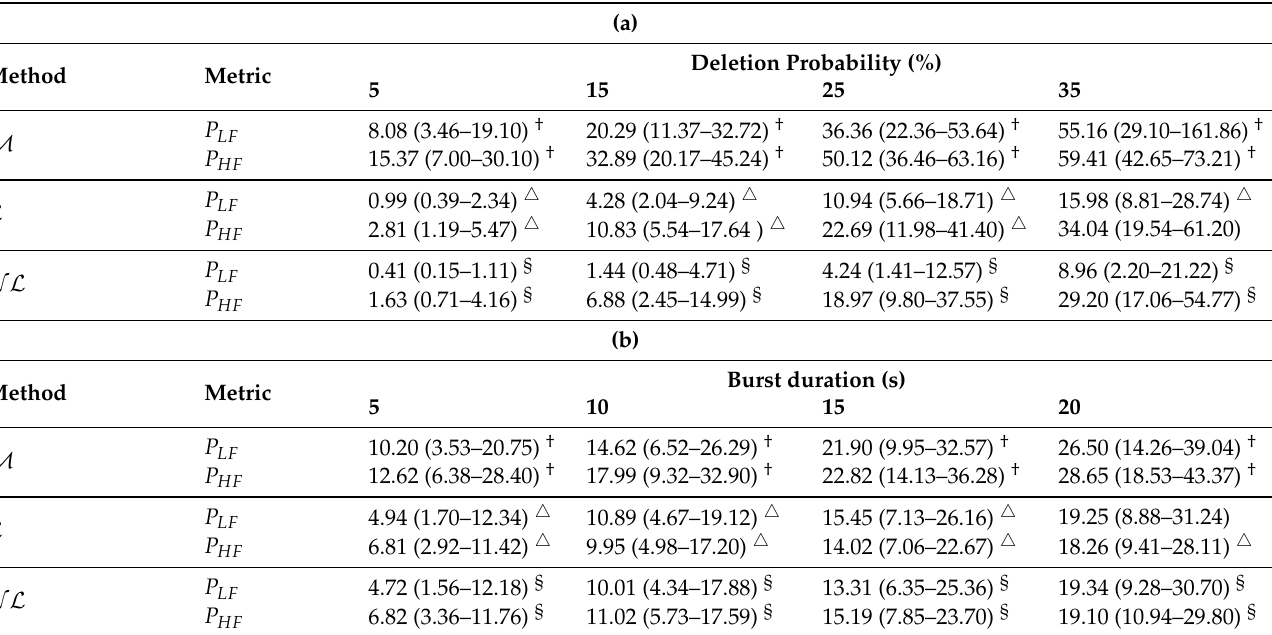
Table 4. Relative error (%) of frequency-domain metrics computed via FFT. (a) Scattered missing beats. (b) Bursts. †: Significant differences ( p < 0.05) between M and L . (cid:52) : Significant differences